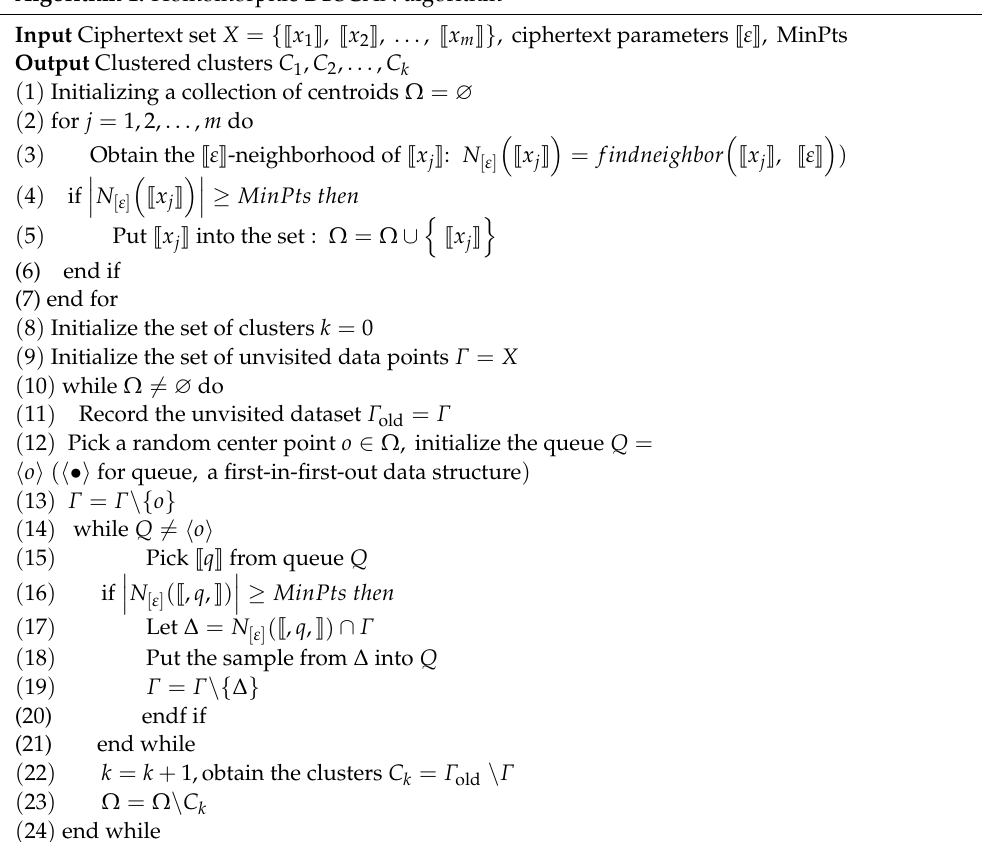
Algorithm 1. Homomorphic DBSCAN